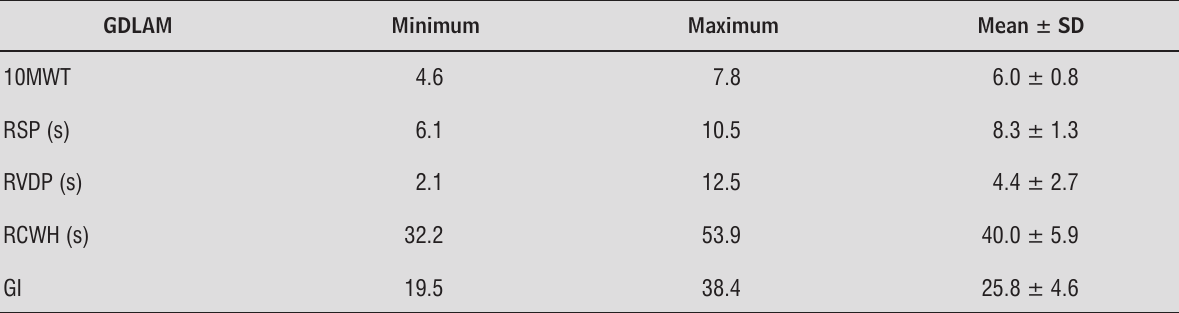
Table 2 - GDLAM protocol